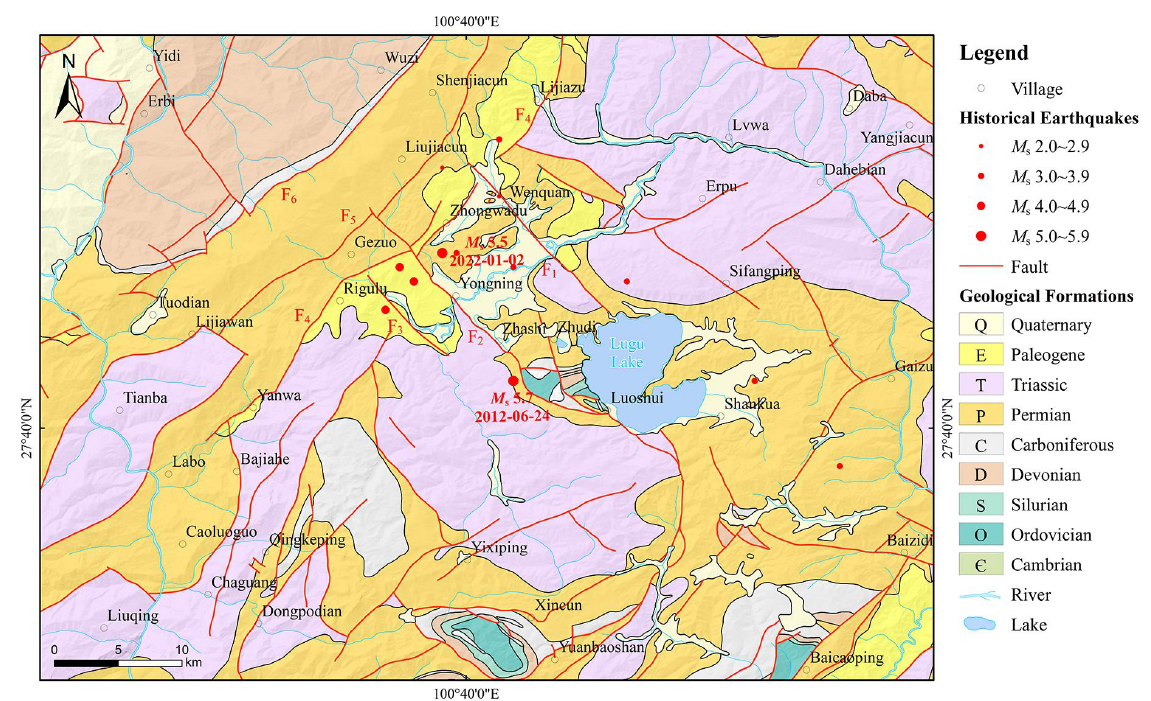
Figure 2. The geological and tectonic map of the Ninglang area. (modified from the 1:200,000 regional geological map of G4705 Yongning [63,64,66], F 1 Wenquan Fault, F 2 Yongning Fault, F 3 Alaao Fault, F 4 Rigulu-Yanwa Fault, F 5 Anjiacun Fault; F 6 Guangxishan Fault).